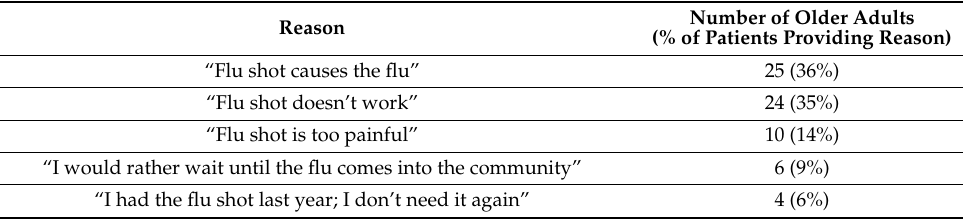
Table 1. Reason for not wanting to receive the influenza